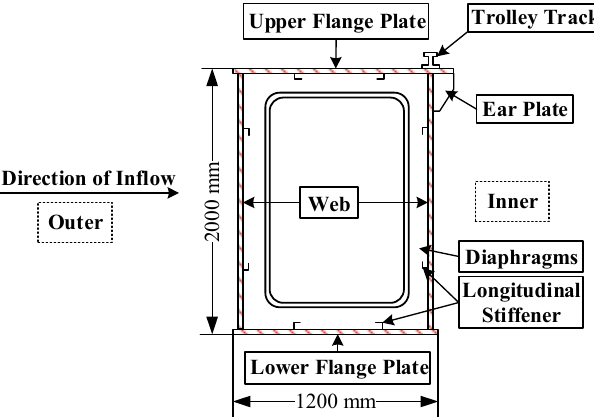
Figure 3. Structural diagram of a 40 t gantry crane box beam.